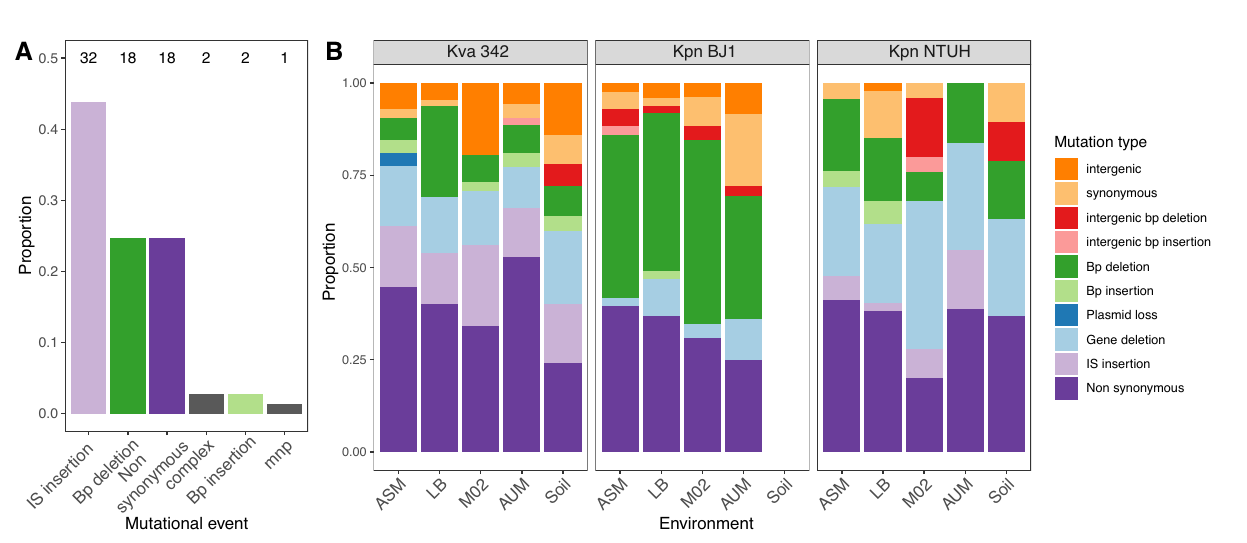
Fig. 3 | Proportion of capsulated clones in the population at the end of the evolution experiment. Each dot re fl ects an independently evolving population. The bar represents the mean of each genotype x environment (up to N =6). Error